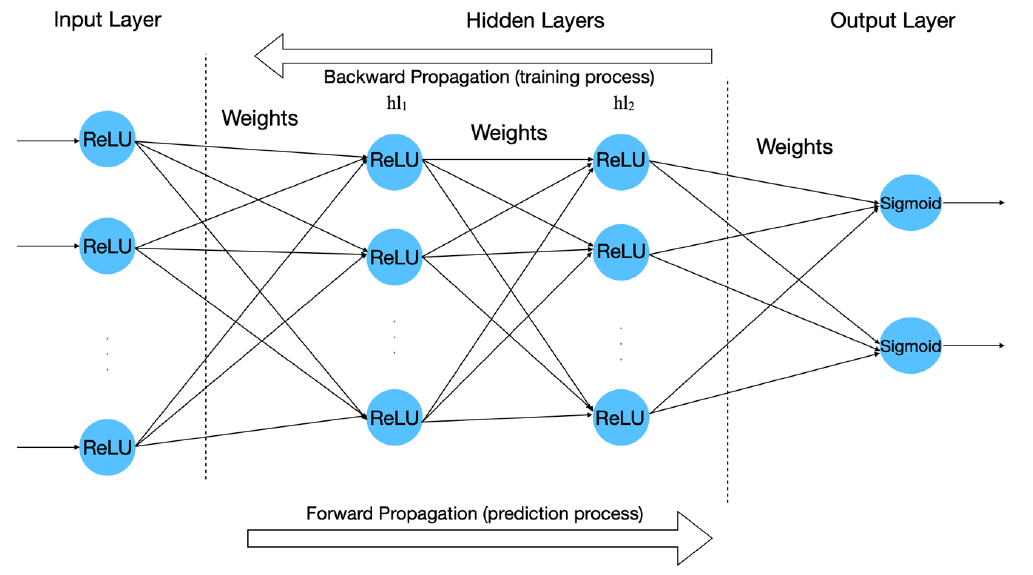
Figure 2. Theoretical DNN